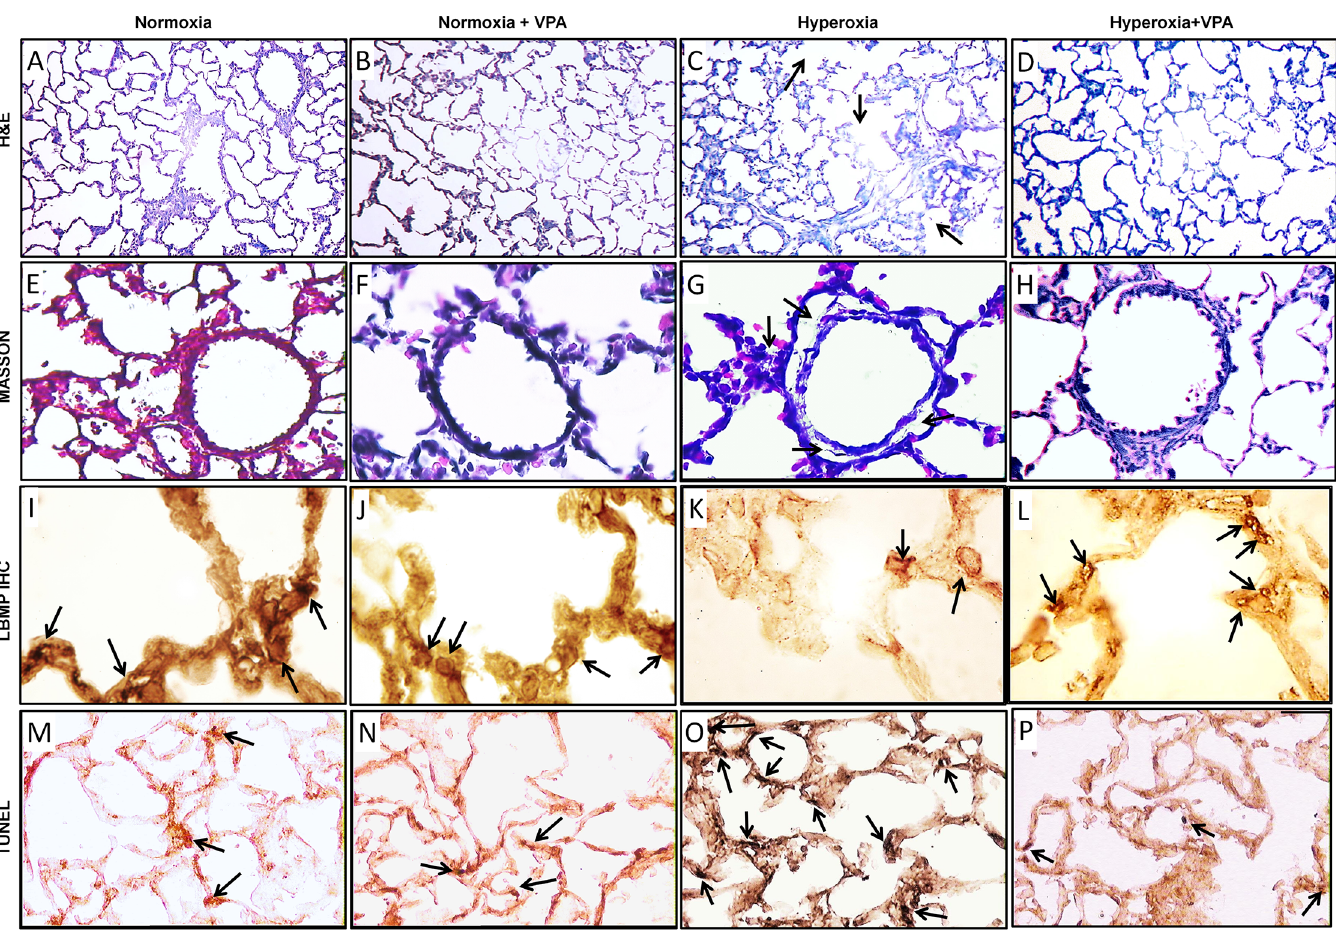
Fig 3. Histological examination of lung tissues by Haematoxylin-eosin (A-D, 100X magnification), Masson ’ s trichrome (E-H, 400X magnification), lamellar body membrane protein (LBMP) (I-L, 1000X magnification), and TUNEL-DAB stainings (M-P, 200X magnification) for Normoxia, Normoxia+VPA, Hyperoxia and Hyperoxia+VPA groups. Representative images show severe alveolar damage (panel C), cell infiltration and edema (panel G, arrow) in Hyperoxia group. Thickening of the alveolar septi or cell infiltration was not observed in Normoxia, Normoxia+VPA and Hyperoxia+VPA groups and panels A, B, D, E, F and H shows healthier and intact lung parenchymal appearance compared to hyperoxia group. Black arrows indicate positive immunoreactivity for LBMP and TUNEL(+) cells in panels I-P.